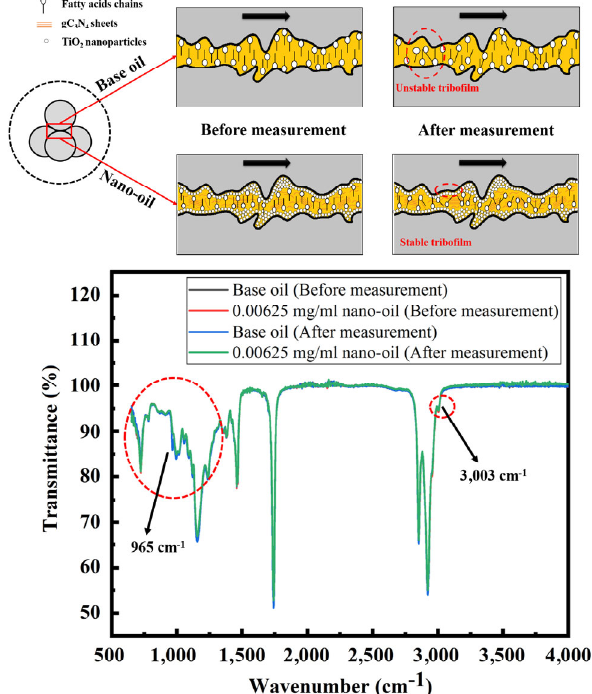
Fig. 6 Interface mechanism of the steel tribo-pair and FTIR spectrum of base and nano-oil before and after